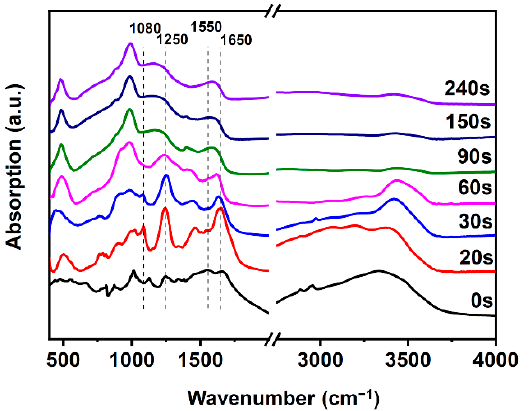
Figure 7. SEM images of char of A3P1 formed at 800 ◦ C with heating time from 20 s to 240 s.